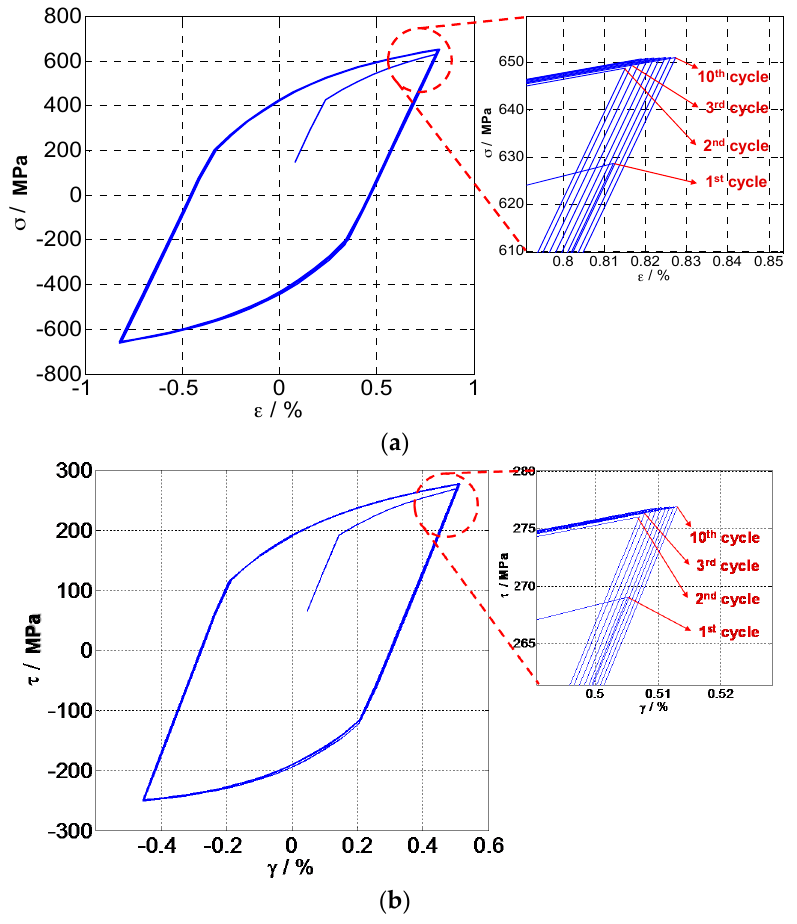
Figure 5. Hysteresis loops of GH4169 at 650 °C: ( a ) Tension-compression and ( b ) Torsion.